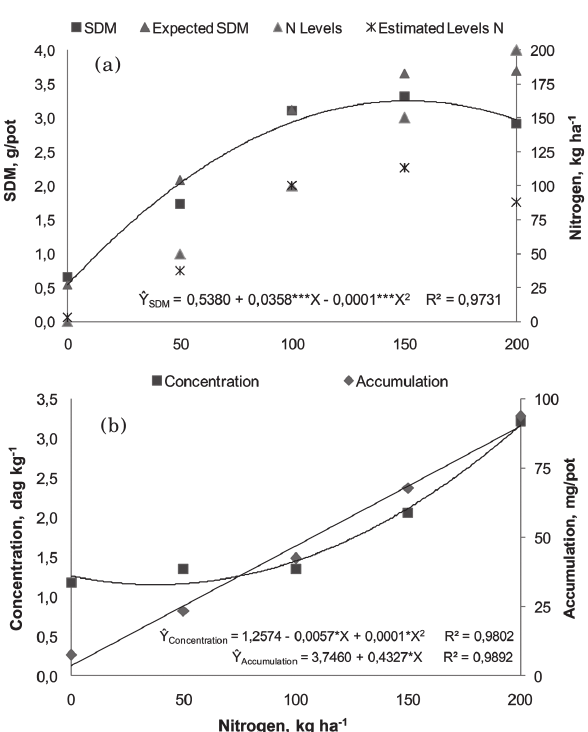
Figure 1. SDM accumulation and expected SDM (left axis) and N doses measured and estimated by SDM using the equation (right axis) (a) and N contents and SDM accumulation in calopo, as a function of applied N